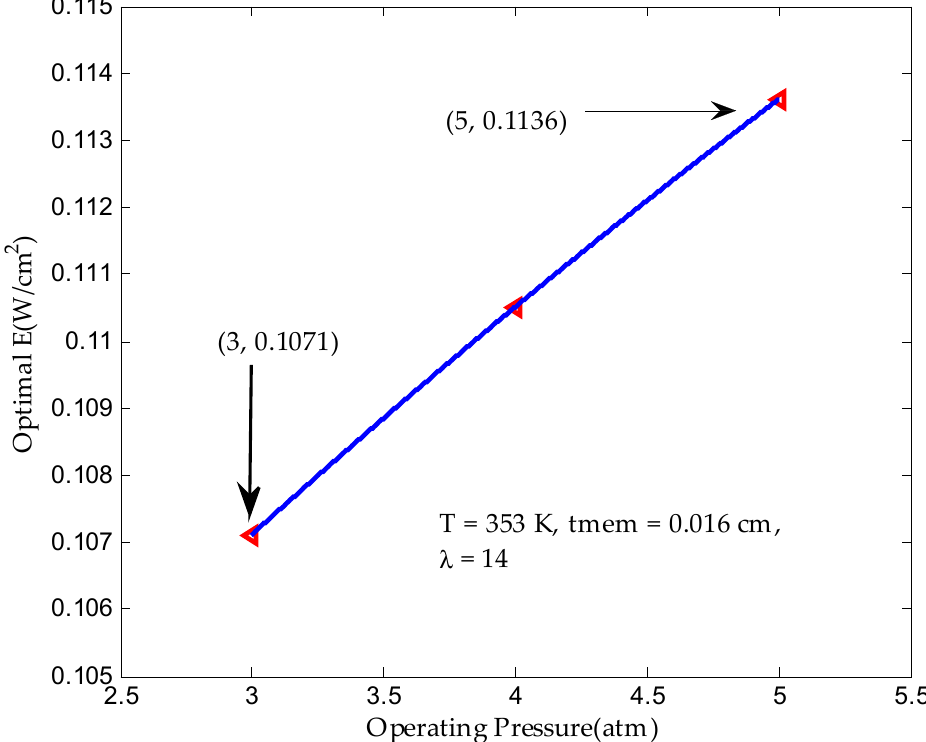
Figure 11. Optimal ecological objective function varying with operating temperature.